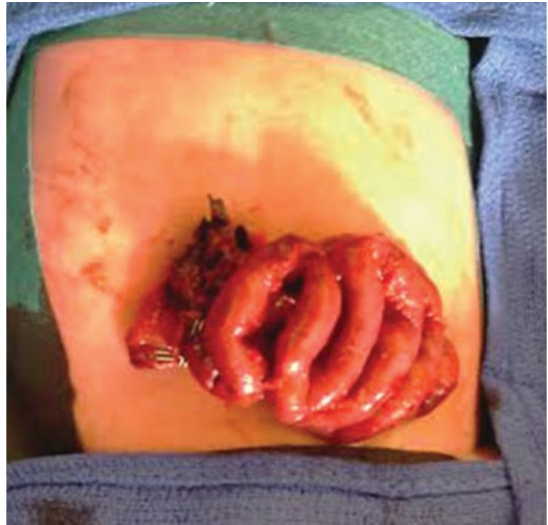
Fig. 2 Macroscopic image of the intestines after tissue plasminogen activator